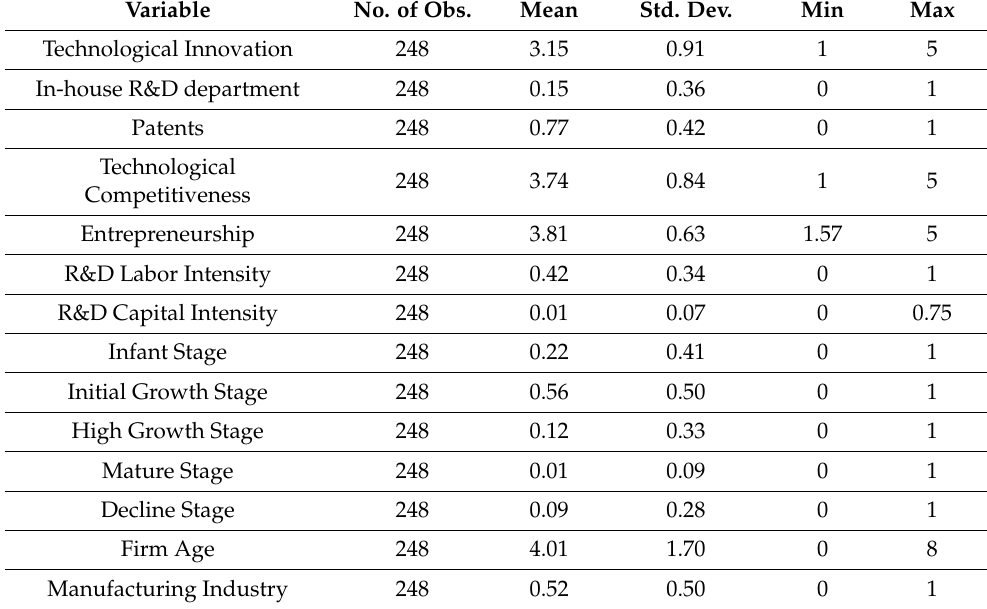
Table A2. Descriptive Statistics of Key